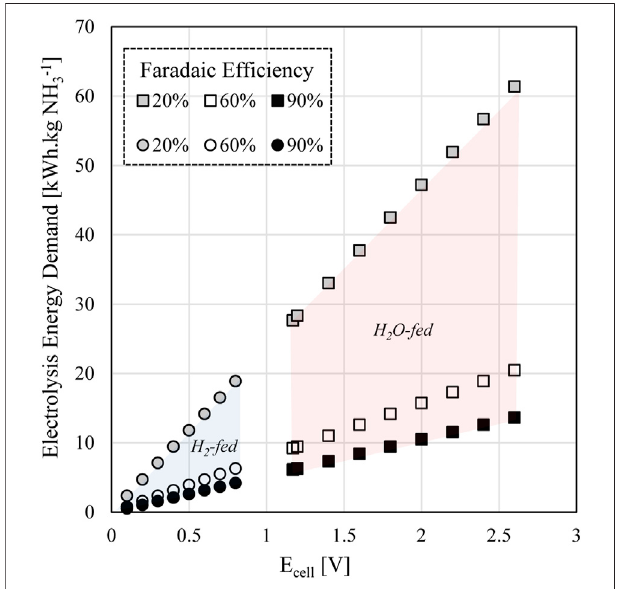
FIGURE 7 | Electrochemical energy demand for hydrogen or water fed ammoniasynthesiscellsdependingonprotonsource(H 2 orH 2 O)andfaradaic ef fi